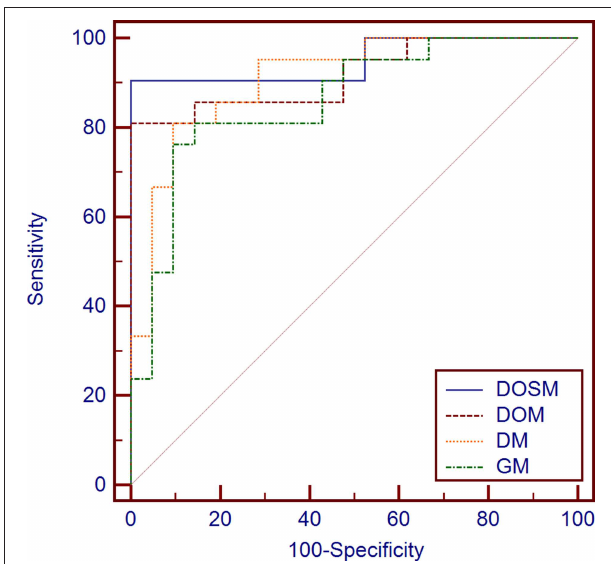
FIGURE 5 | Diagnostic performances of different MVI prediction models. While comparing the AUC curves between DOSM, DOM, DM, and GM models. The AUC of DOSM (95.01%, 0.835–0.993) was the highest one among the DOSM, DOM, DM, and GM models. The AUC of GM (85.94%, 0.717–0.947) was the lowest. The AUC of DOSM is 0.95 ± 0.04, which is the highest one among the four MVI prediction models.